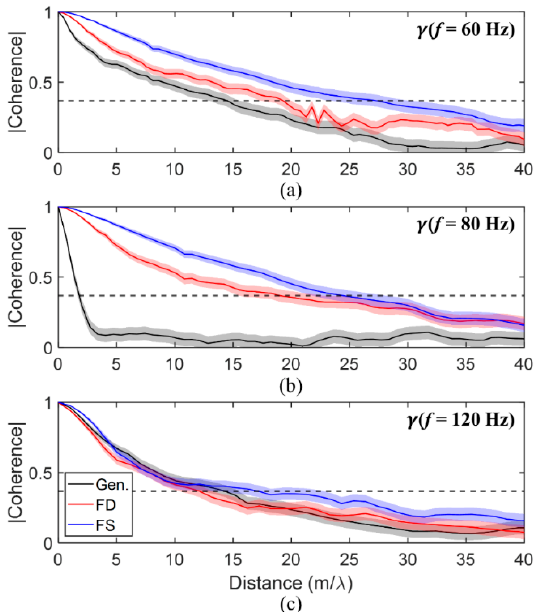
Figure 5. Coherence vs. distance (normalized by wavelength) comparison for frequencies obtainable by all three fields. The genuine in-band field is shown in black, the frequency-difference autoproduct is shown in red, and the frequency-sum autoproduct is shown in blue. The horizontal dotted black line is the e − 1 threshold value for coherence length. Confidence intervals estimated from (10) and (11) are indicated as semitransparent regions, and the frequency used is displayed in the upper right of each panel for 60 Hz ( a ), 80 Hz ( b ), and 120 Hz ( c ).